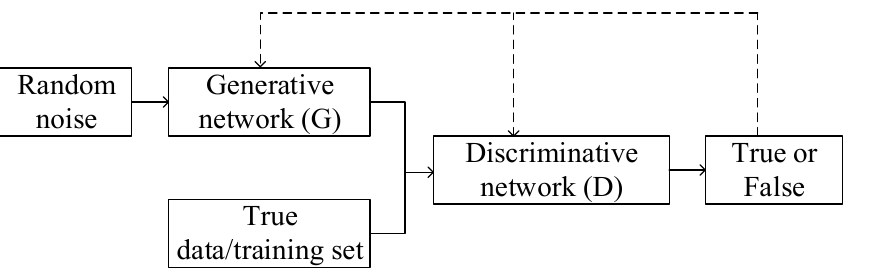
Figure 3. Generative adversarial network (GAN).